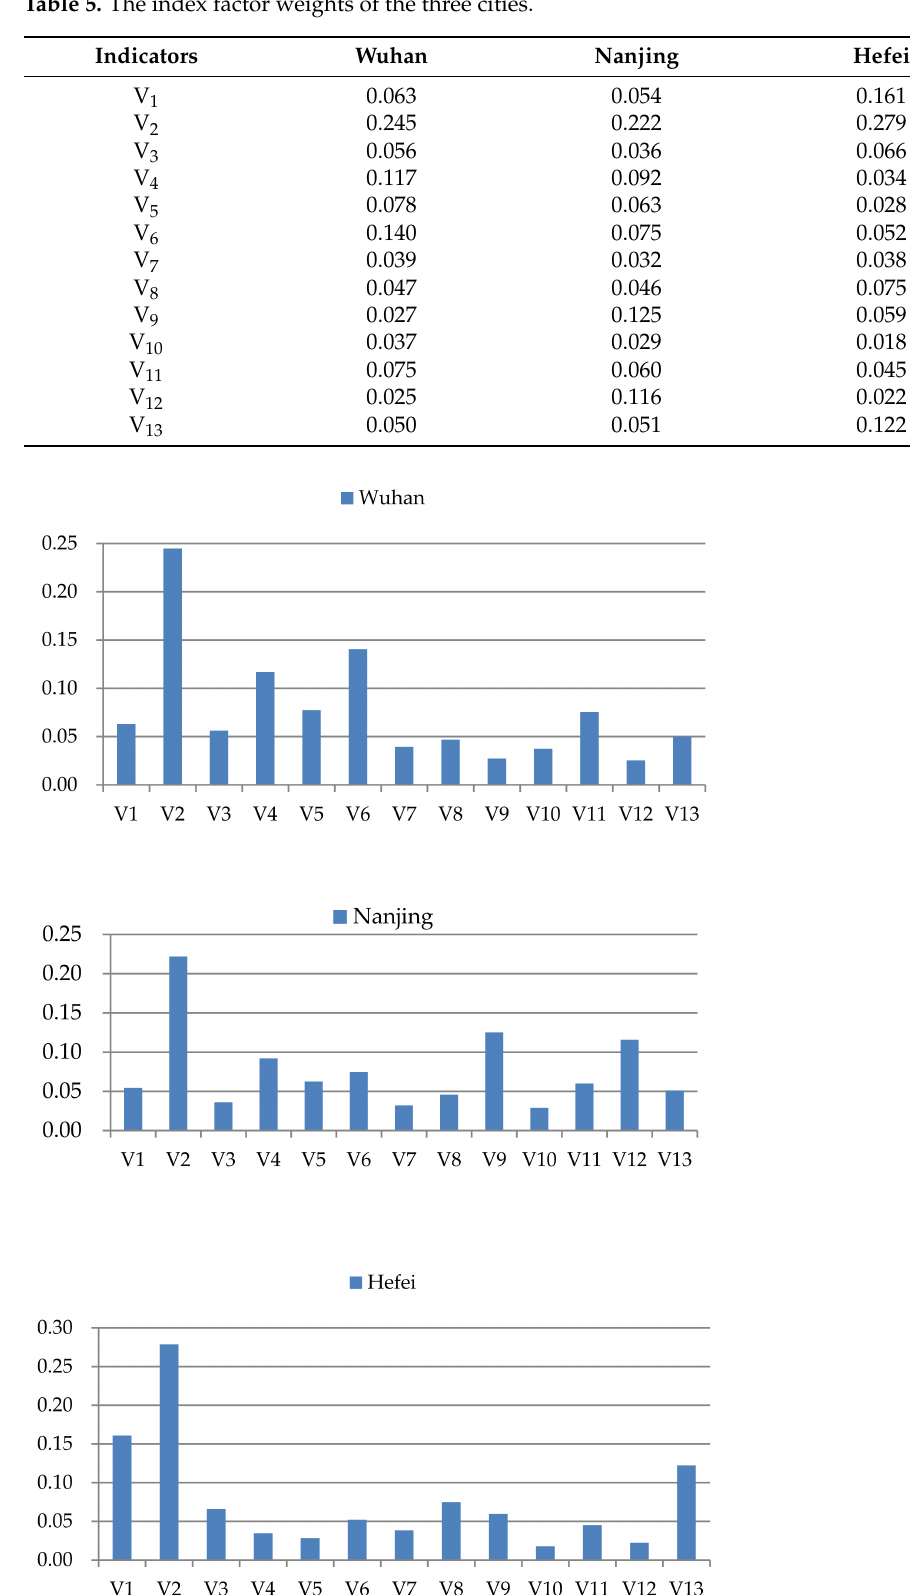
Table 5. The index factor weights of the three cities.